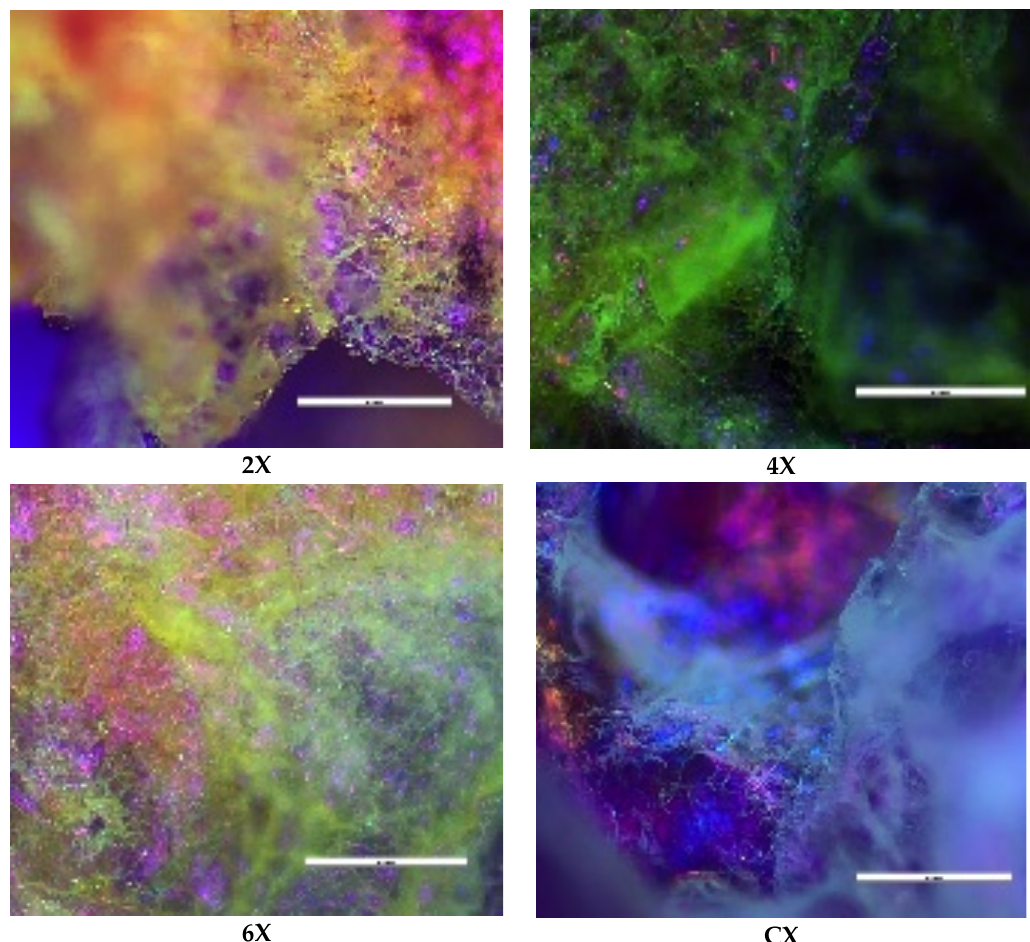
Figure 4. Representative POM images of the xerogels (scale bar: 100 μ m).